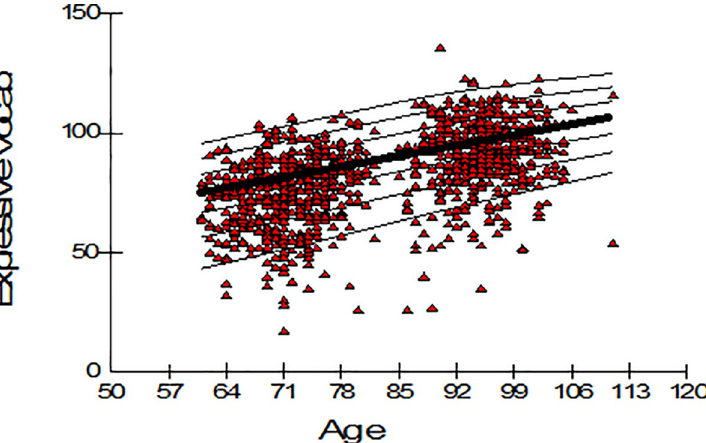
Fig 5. Centile curves for the expressive one word picture vocabulary test. Weighted centile curves for the Expressive One Word Picture Vocabulary test based on the intensively assessed sample at Year 1 and Year 3 (n = 1,027). The bold curve depicts the median centile curve and the thin lines the 3 rd , 10 th , 25 th , 75 th , 90 th and 97 th centile curves.